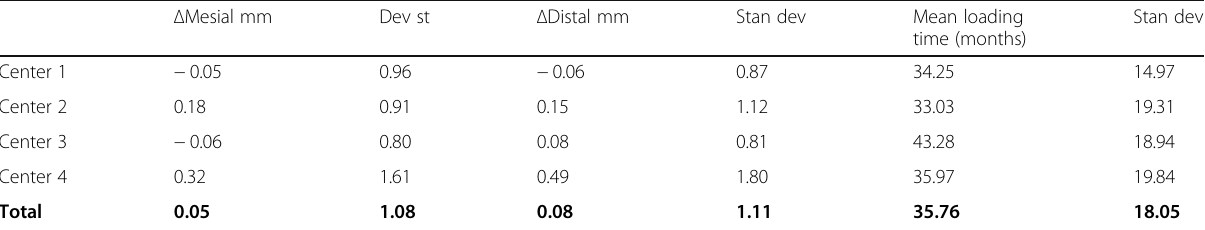
Table 3 Mean differential of peri-implant bone loss/gain (mesial and distal) between T0 (implant placement) and T2 (last recall). The minimum follow-up period was set at 1 year post-functional